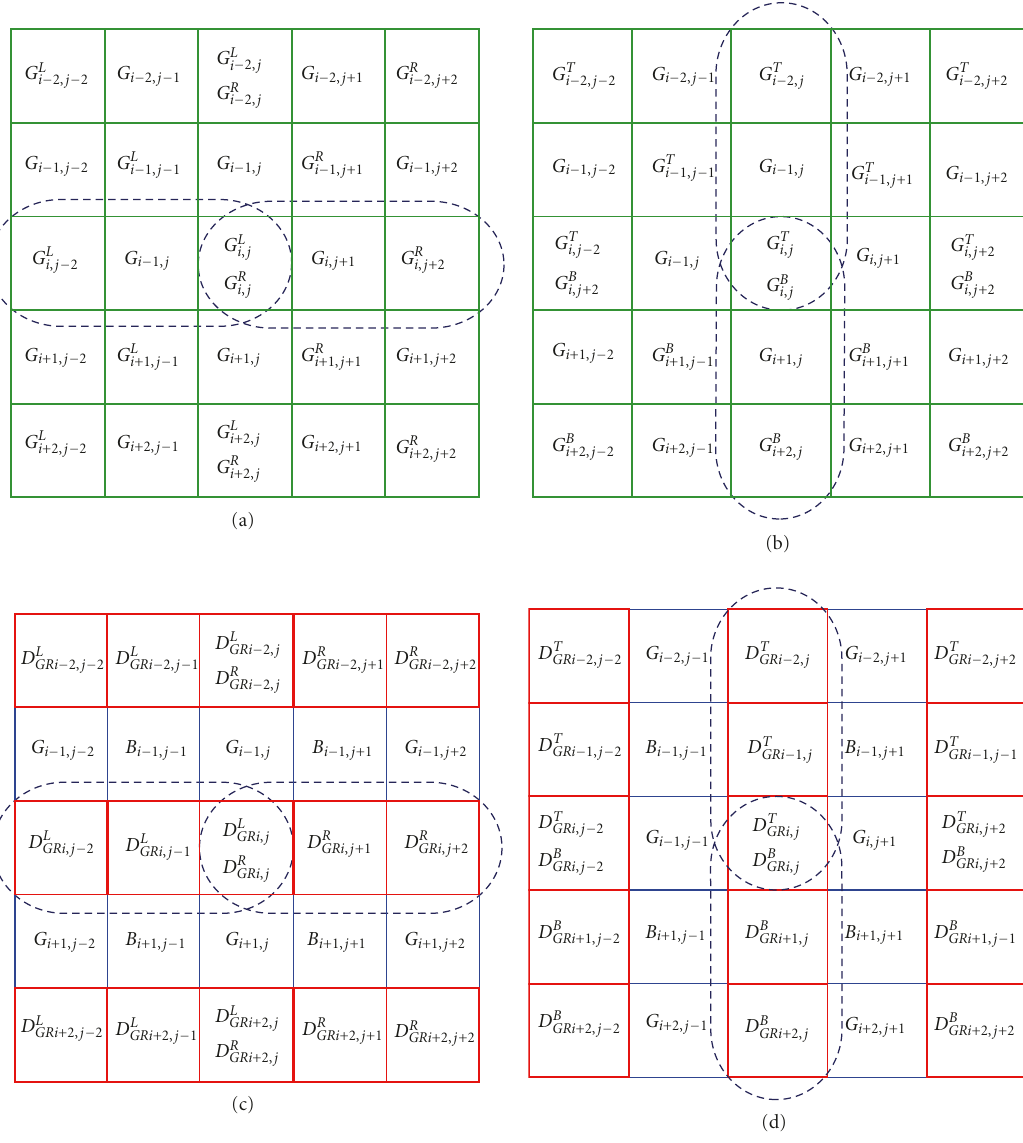
Figure 10: Flat and edge region: (a) left and right for the G channel, (b) top and bottom for the G channel, (c) left and right for the K R channel, and (d) top and bottom for the K R